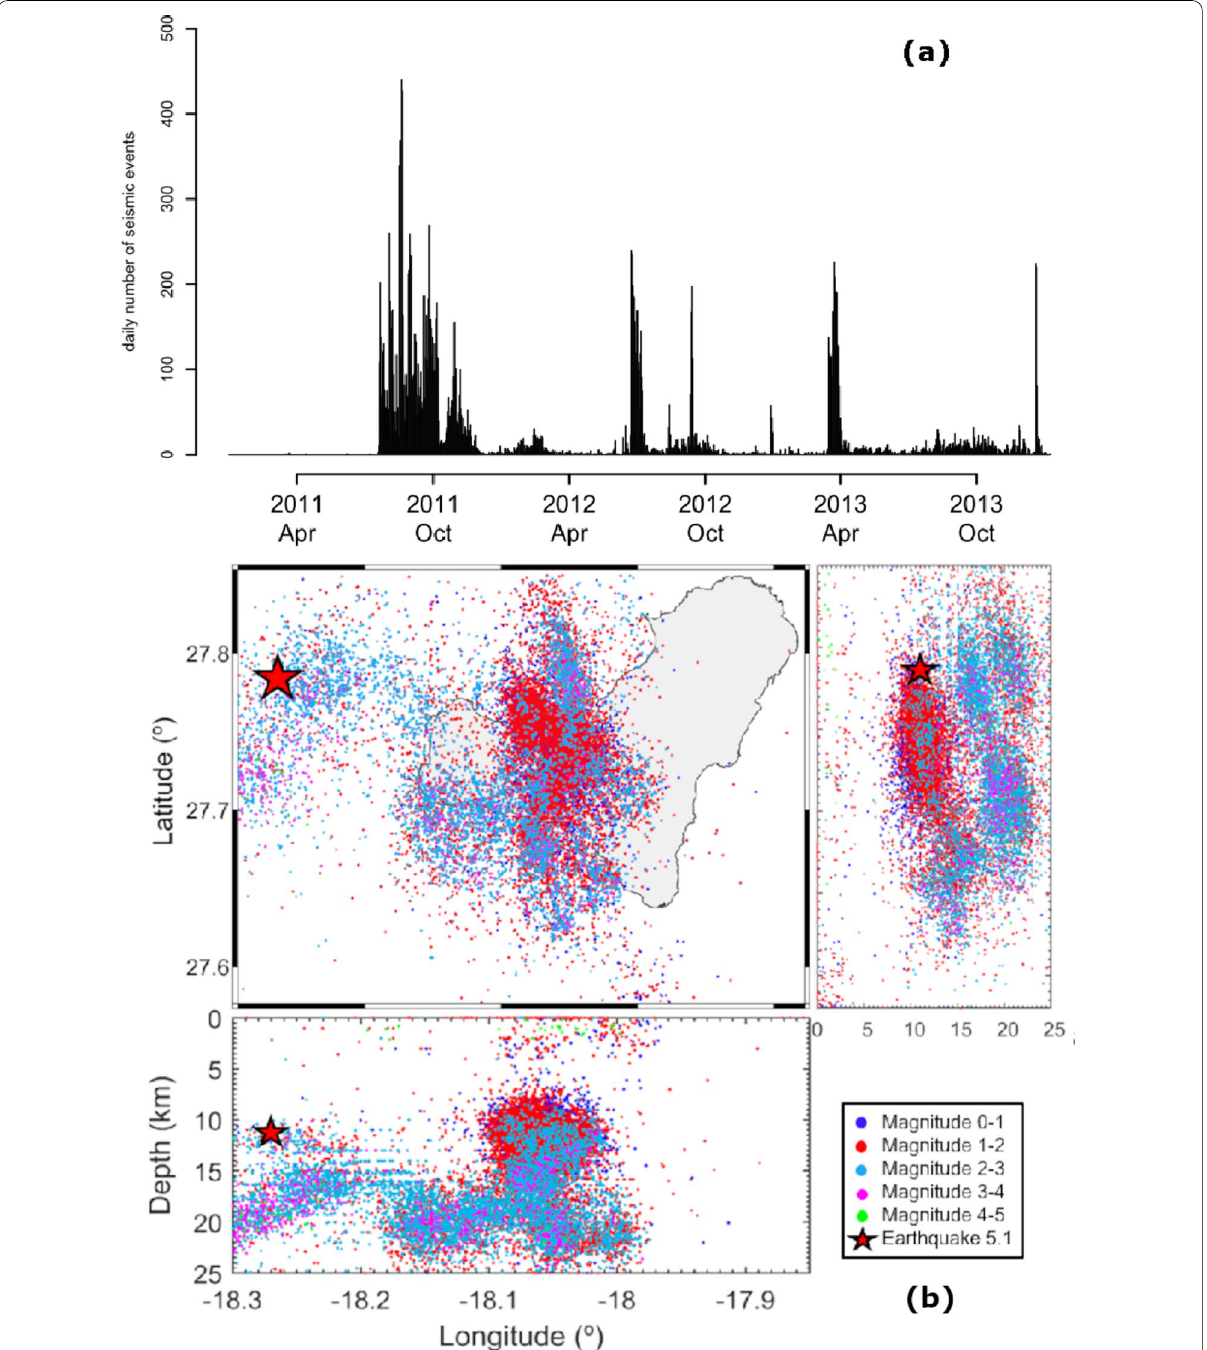
Fig. 2 Daily number of earthquakes and its location in El Hierro island between 2011 and